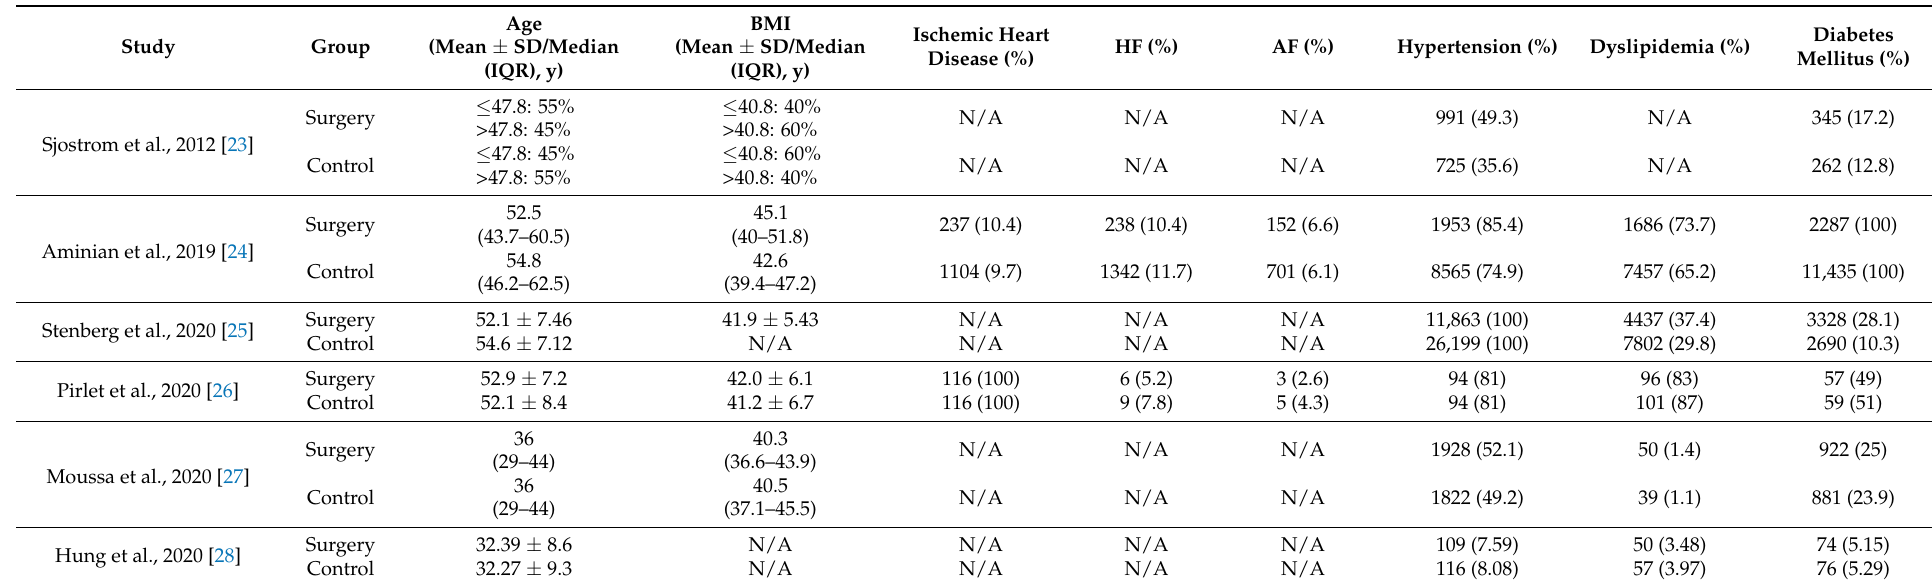
Table 2. Characteristics of the study